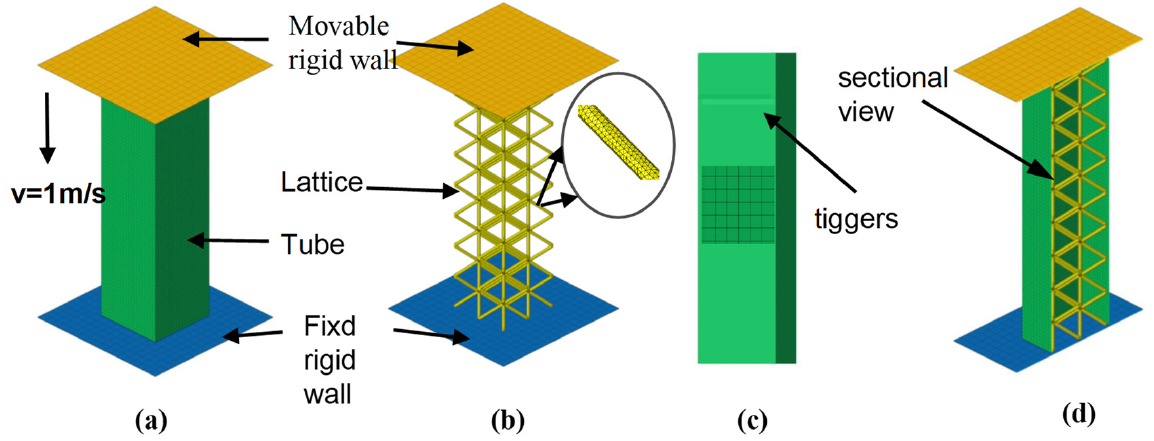
Figure 7. Finite element model of the hybrid structure ( a ) Thin-walled tube finite element model ( b ) Lattice finite element model ( c ) Tiggers ( d ) Finite element model section.